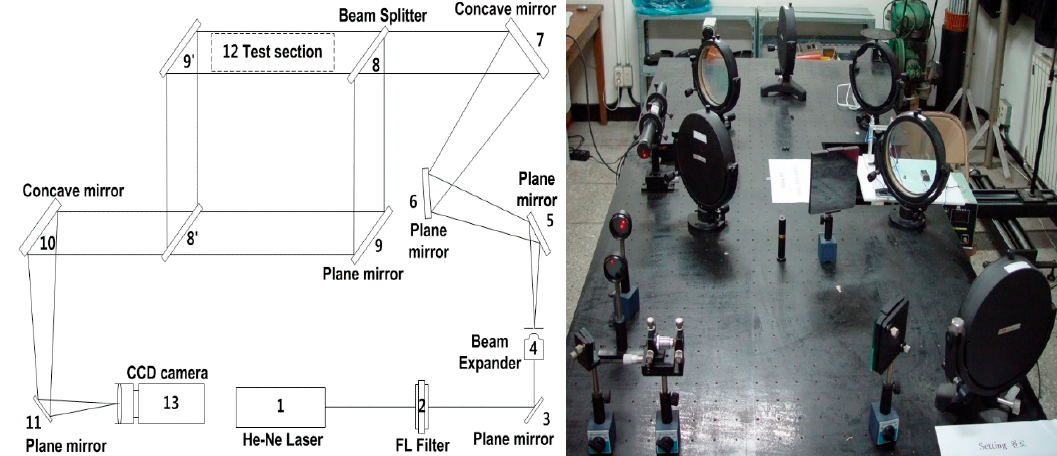
Figure 2. Schematic diagram and real image of Mach–Zehnder interferometer in this